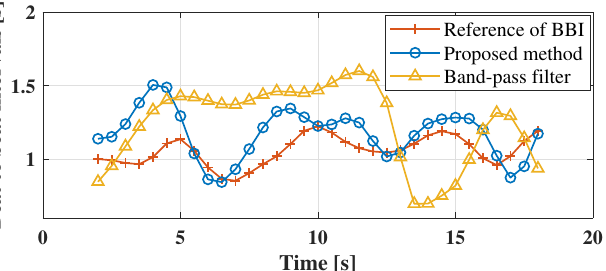
Figure 10. Comparison of heart rate interval plots estimated by the proposed method and band- pass